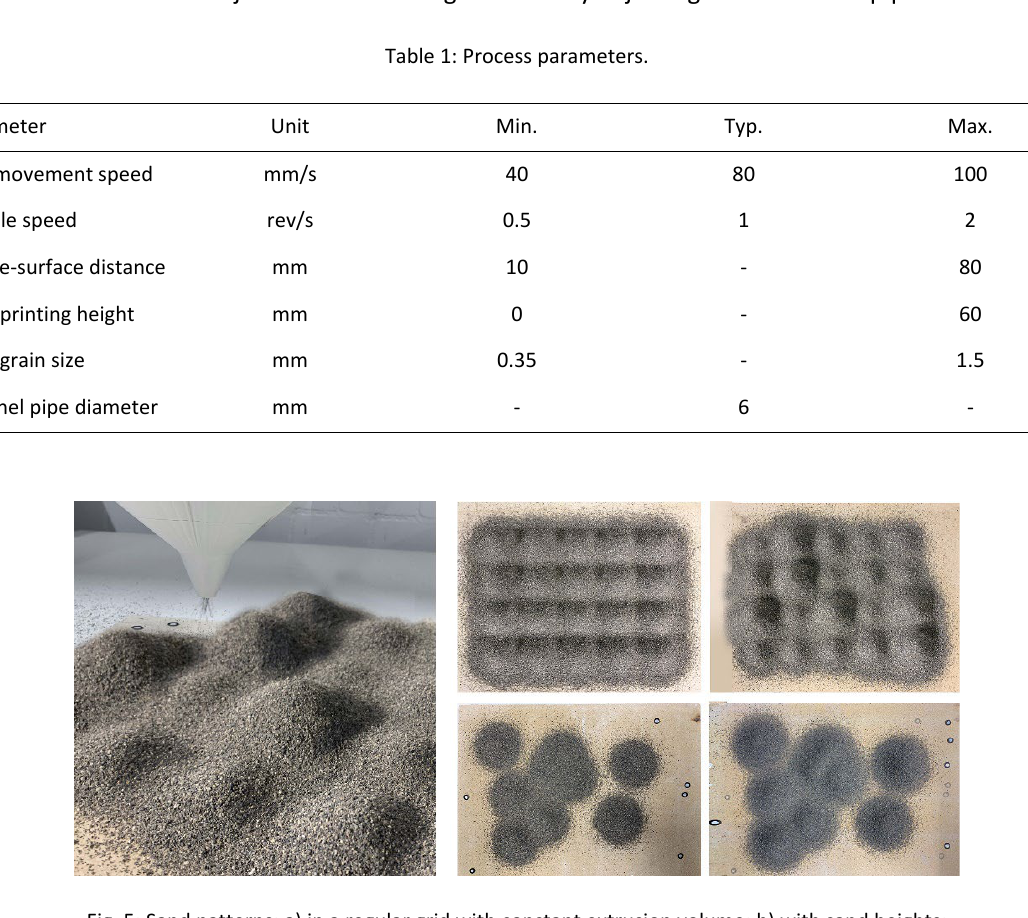
Fig. 5: Sand patterns; a) in a regular grid with constant extrusion volume; b) with sand heights; c) in a shuffled grid with even volumes; d) with varying sand